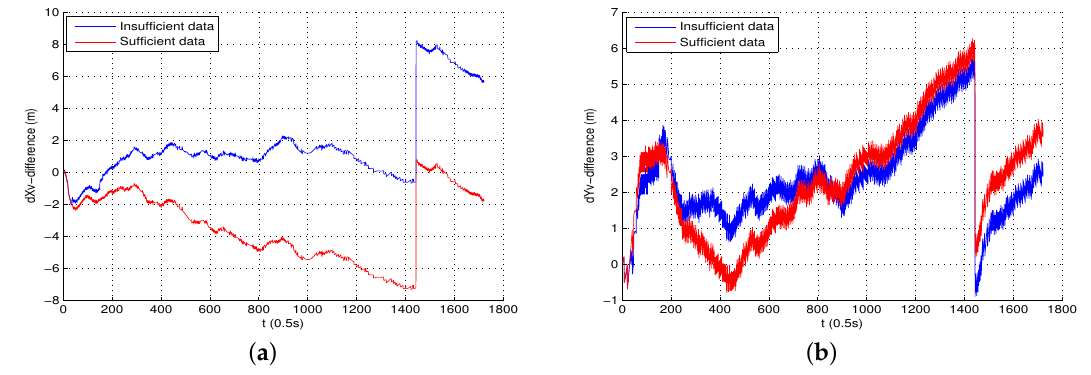
Figure 22. Deviation between estimated position and true position of M-DS recorded by IMU in AUV homing to the M-DS are illustrated by that in ( a ) X direction and ( b ) Y